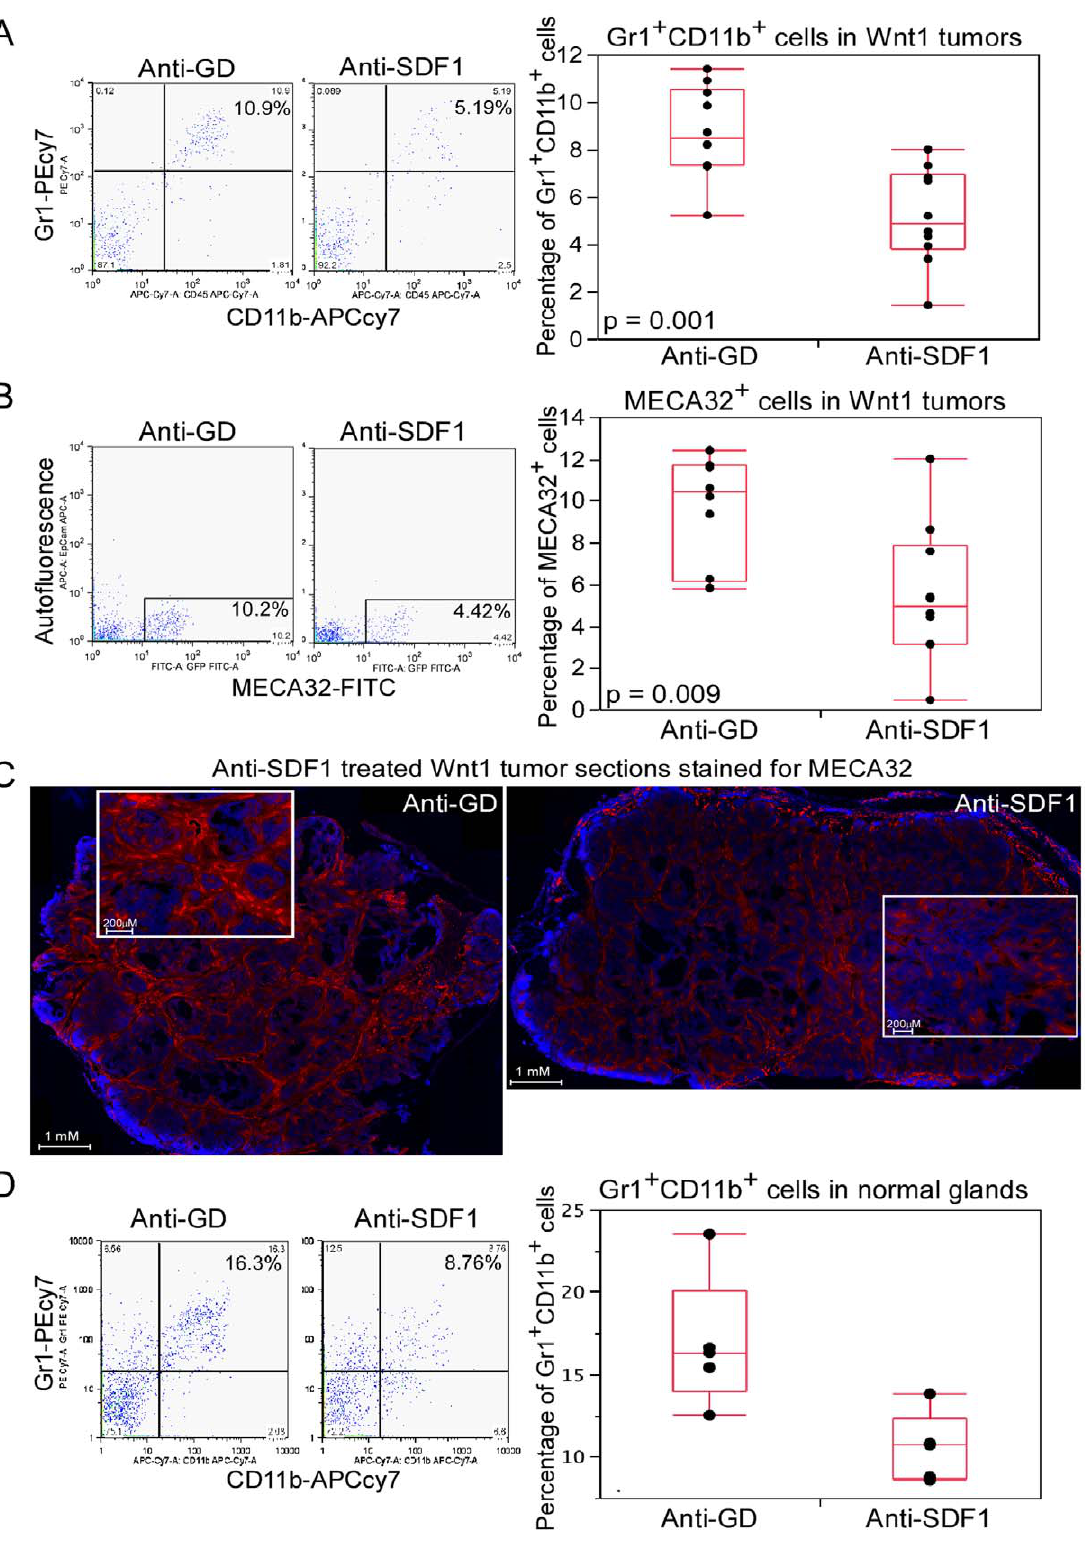
Figure 5. Assessment of BMDC contributions and endothelial cell content in Wnt1 tumors and normal mammary glands following anti-SDF1 treatment. FACS profiles and box plots of percentage of Gr1 + CD11b + cells (A) and MECA32 + cells (B) in Wnt1 tumors (n=10) following four days of anti-SDF1 treatment. C, immunofluorescent staining of Wnt1 tumor sections with anti-MECA32 antibody (red) and DAPI (blue) following four days of anti-SDF1 treatment. Entire tumor section was assembled from , 100 images taken by fluorescent microscope with a 10X objective, and inserts are zoom in depictions of that particular sections. D, FACS profiles and box plots of percentage of Gr1 + CD11b + cells in normal virgin mammary glands following four days of anti-SDF1 treatment.